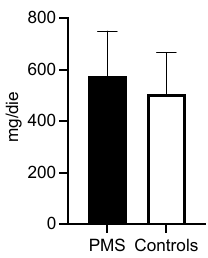
Figure 2. Estimated daily tryptophan intakes in participating women. Tryptophan intakes were calculated based on food diaries in both women with PMS and control women. This amino acid is a precursor of serotonin, and lower intake of this element has been associated with PMS [28,29]. No significant differences in tryptophan intake were found between the PMS group and the control group.